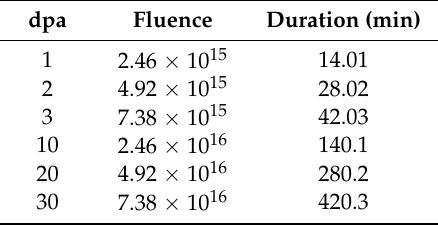
Table 2. The parameters of ion-irradiation.